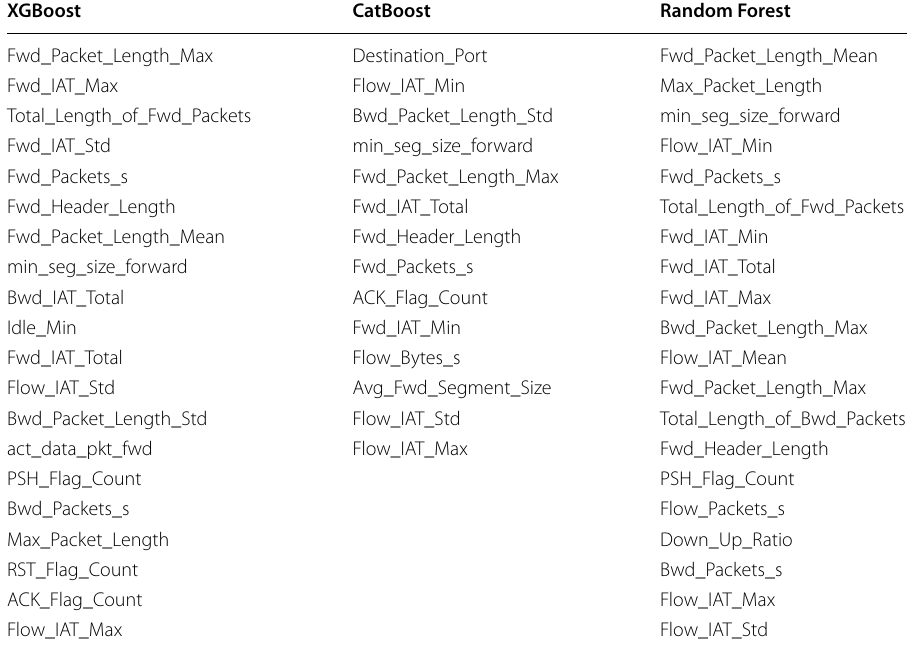
Table 7 Top 20 CSE-CIC-IDS2018 features by supervised ranking technique: XGBoost, Random Forest; due to hyper-parameter settings, CatBoost uses only 14 features XGBoost CatBoost Random